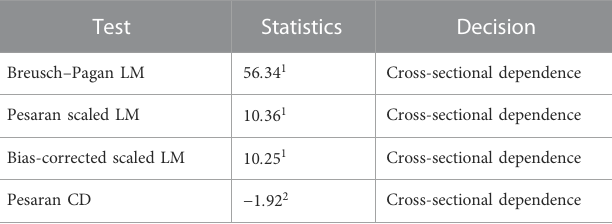
TABLE 1 Cross-sectional dependence test.